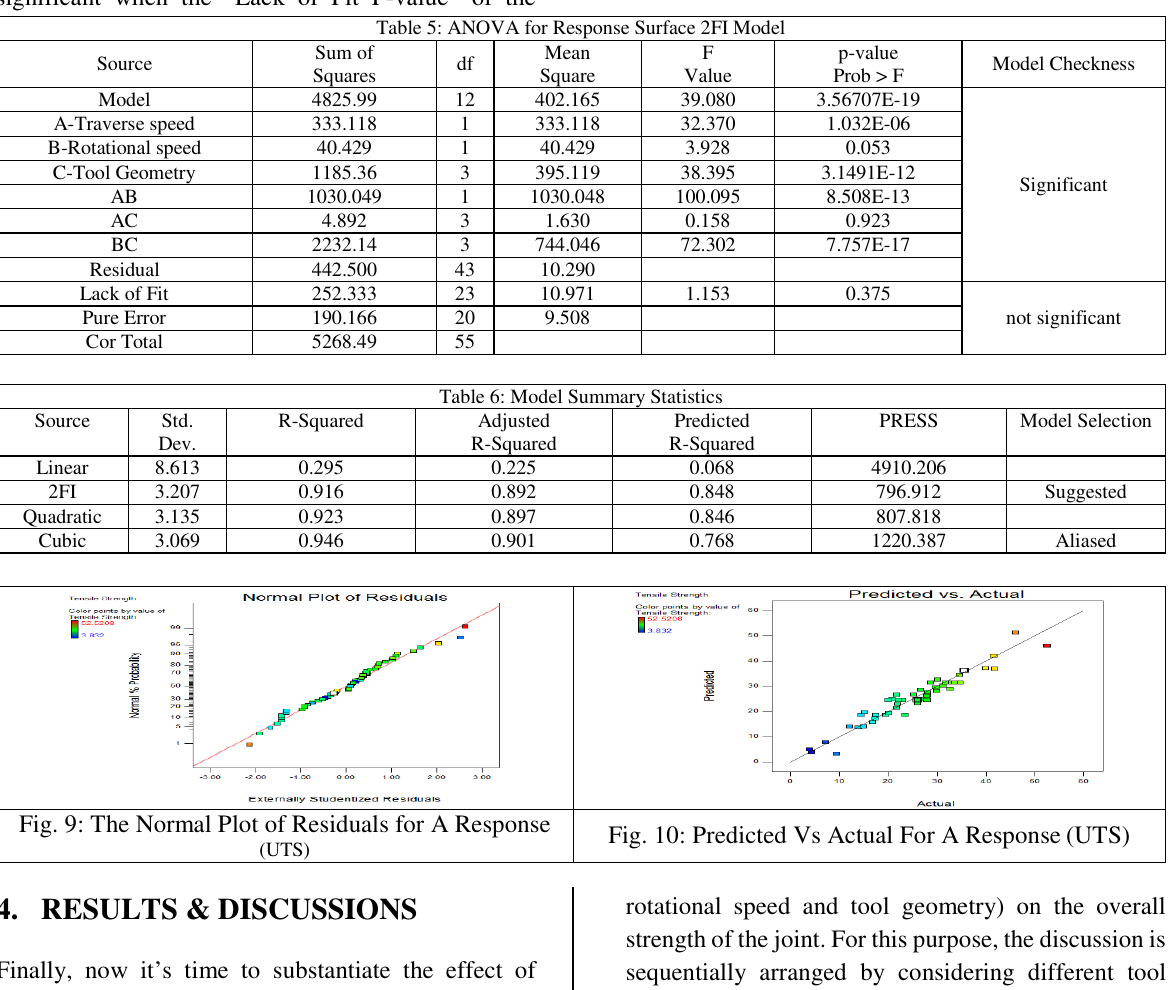
Fig. 10: Predicted Vs Actual For A Response